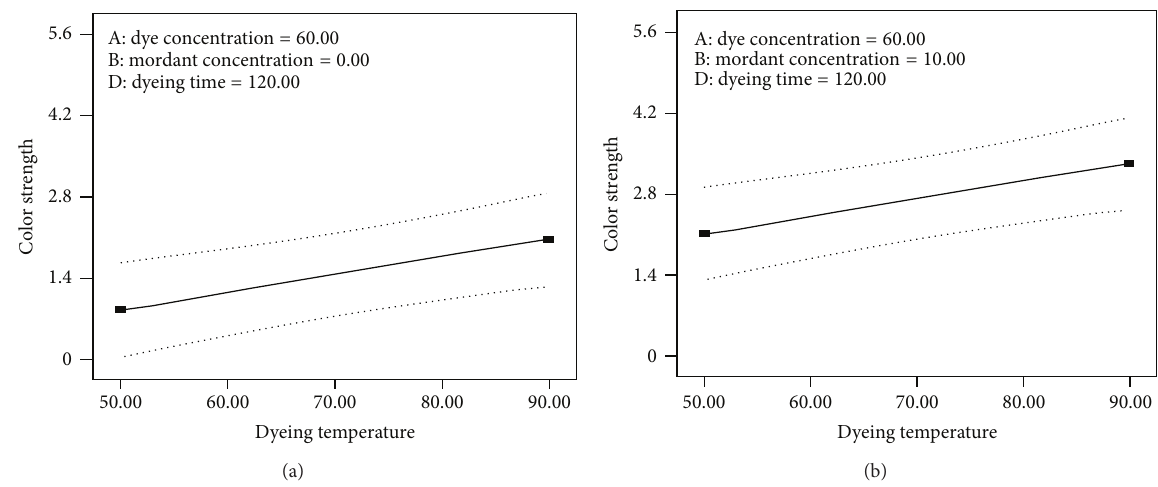
Figure2:Theeffectofdyeingtemperatureonthecolorstrengthofdyedwoolfiberswith Prangosferulacea